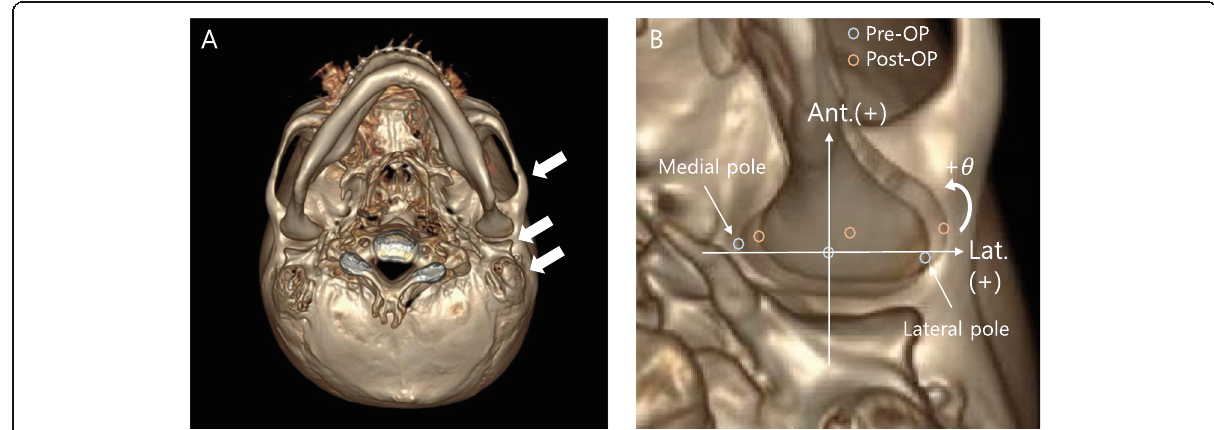
Fig. 4 Axial view in 3D-CT: The reference points. A The anterior margin of the bilateral zygomatic arch, the posterior glenoid fossa, and the mastoid processes of both temporal bones. B Superimposed plane. the midpoint was designated on the axis connecting the medial and lateral poles of the condylar head. In the mediolateral displacement, positive values indicate the lateral direction. In the anteroposterior displacement, the positive values mean the anterior direction. For condyle rotation, the positive values mean inward rotation of condyle head